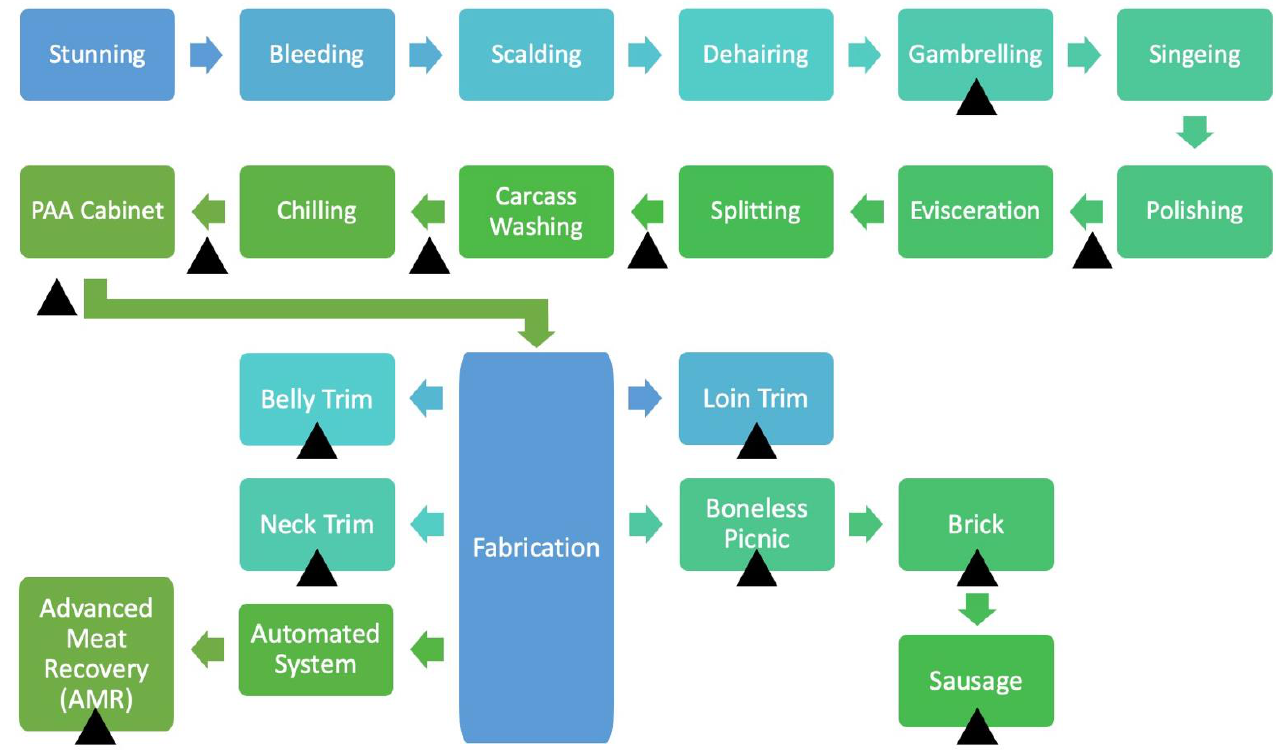
Figure 1. Schematic representation of the pork processing line. Sampling locations are indicated by solid triangles.